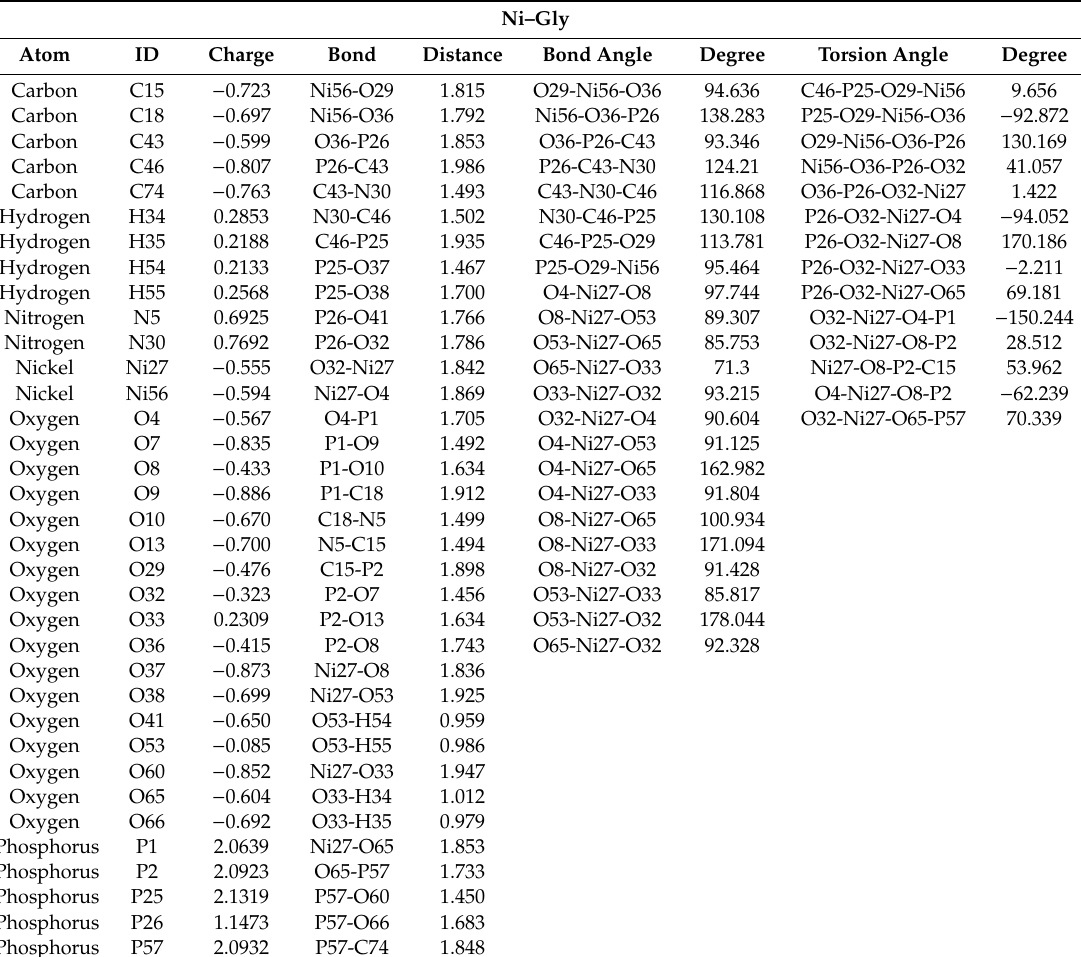
Table 5. Geometric properties of the Ni–Gly model.